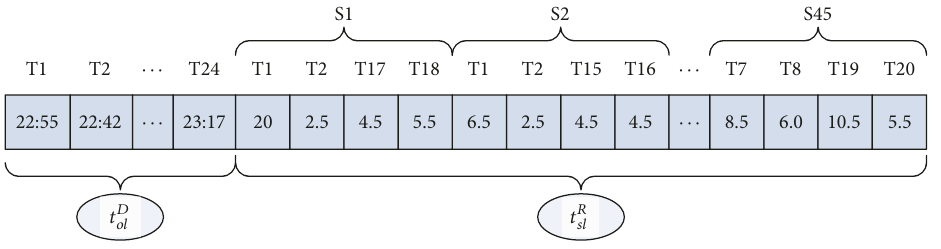
Figure 3: Solution representation.